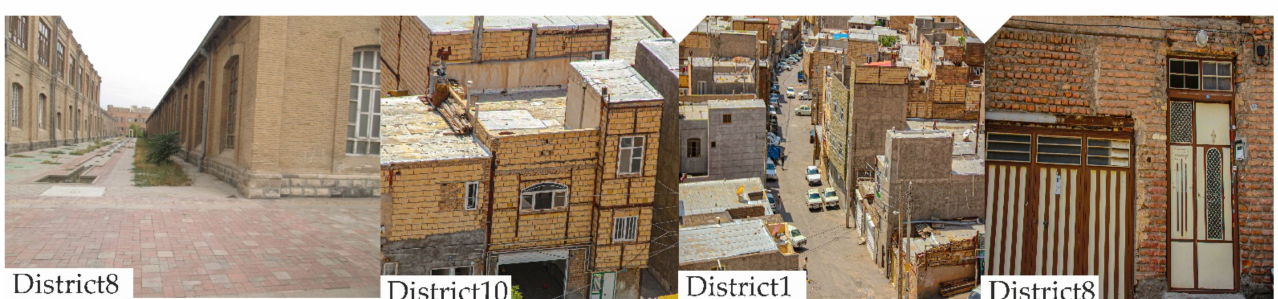
Figure 13. Surrounding masonry wall with an interior steel column.